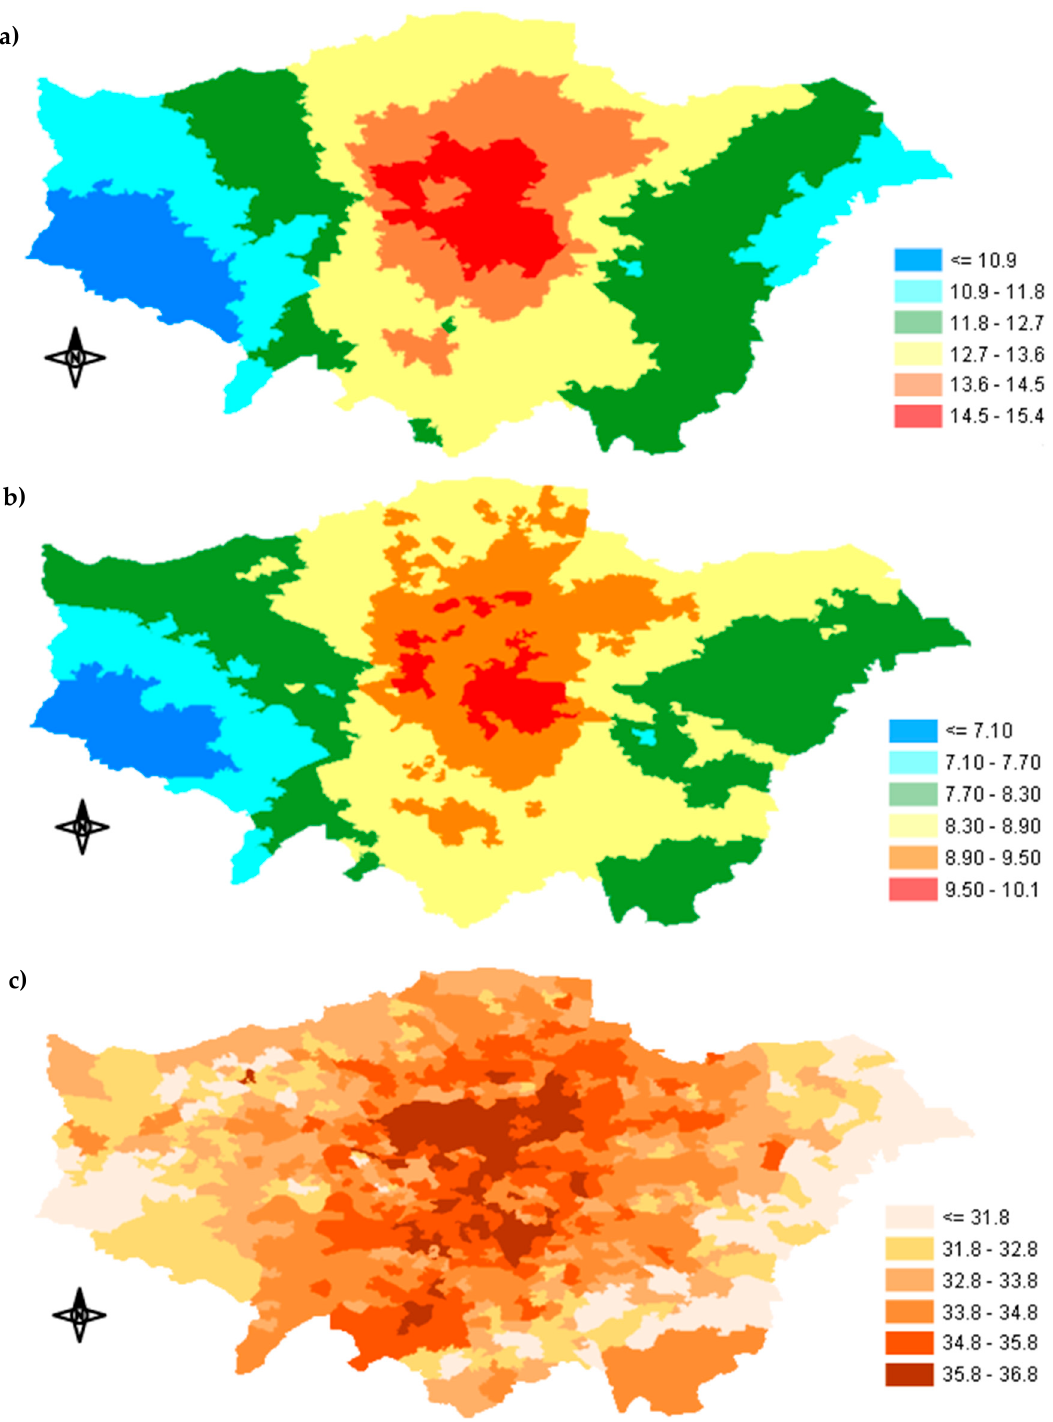
Figure 3. Maps of annual distributions across the Greater London Area (GLA): ( a ) Tier-model 1 annual mean PM 2.5 exposure concentration ( μ g/m 3 ), ( b ) Tier-model 5 annual mean PM 2.5 exposure concentration ( μ g/m 3 ), and ( c ) percentage of the PM 2.5 exposure concentration difference between Tier-model 1 and Tier-model 5.